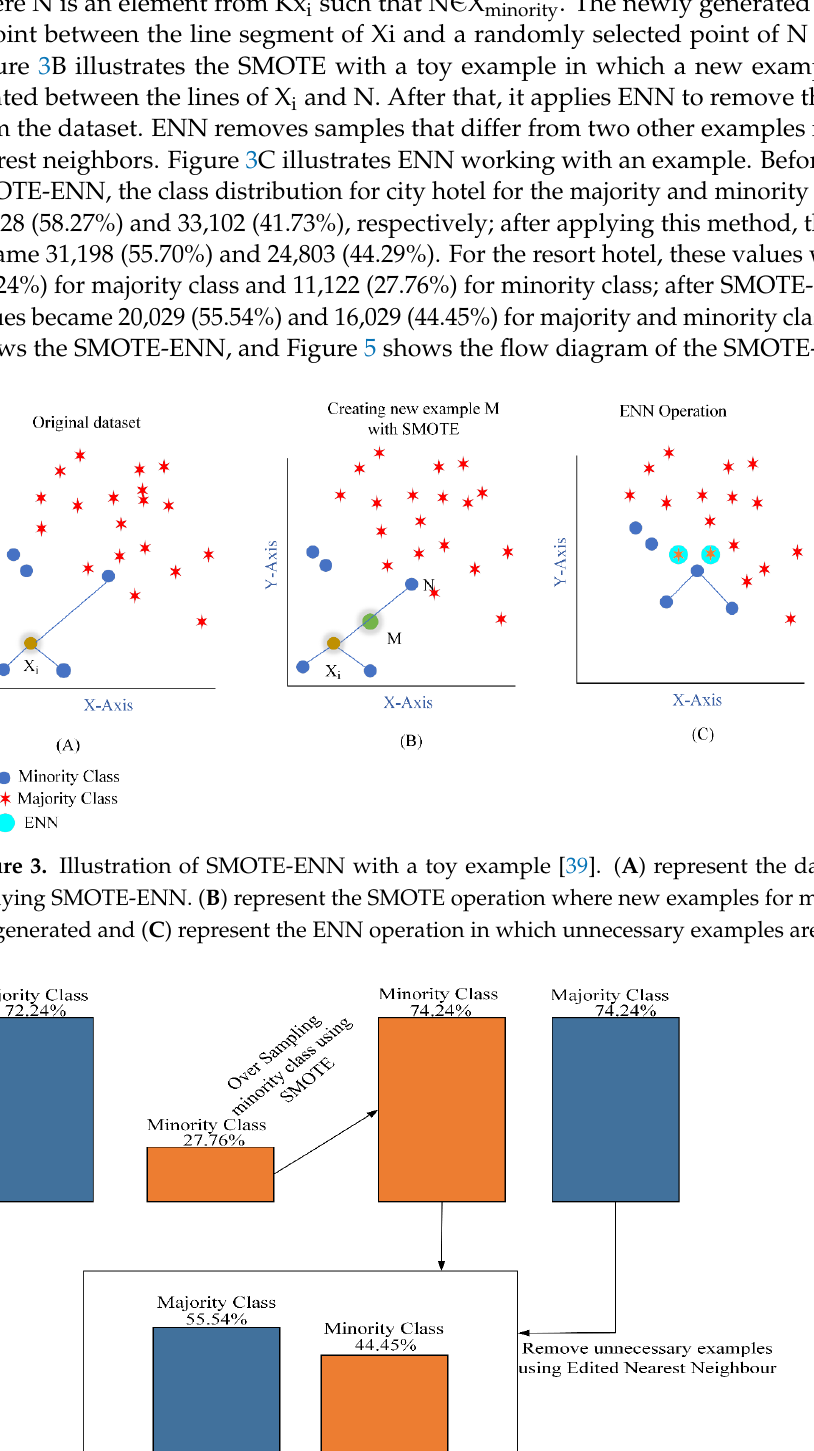
Figure 5. Flow diagram of SMOTE-ENN [39].